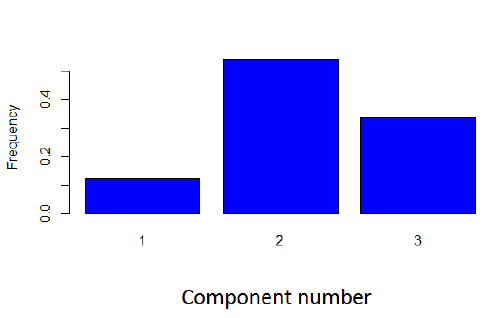
Fig. 5: P(z) matrix generated by the PLSA algorithm for the ten S. aureus strains